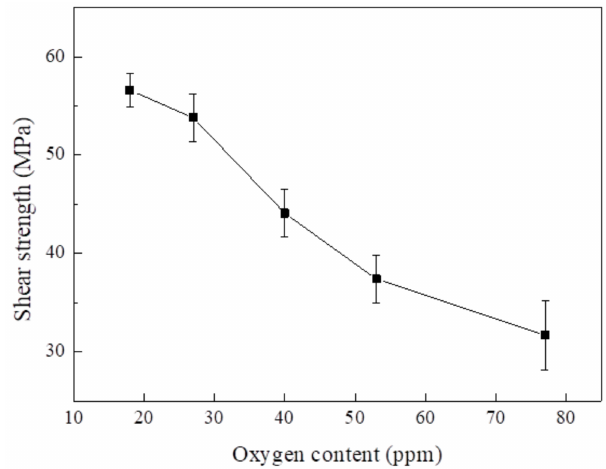
Figure 4. Evolution in shear strength of the Au-Sn/Cu joints with increasing oxygen content in the solder.